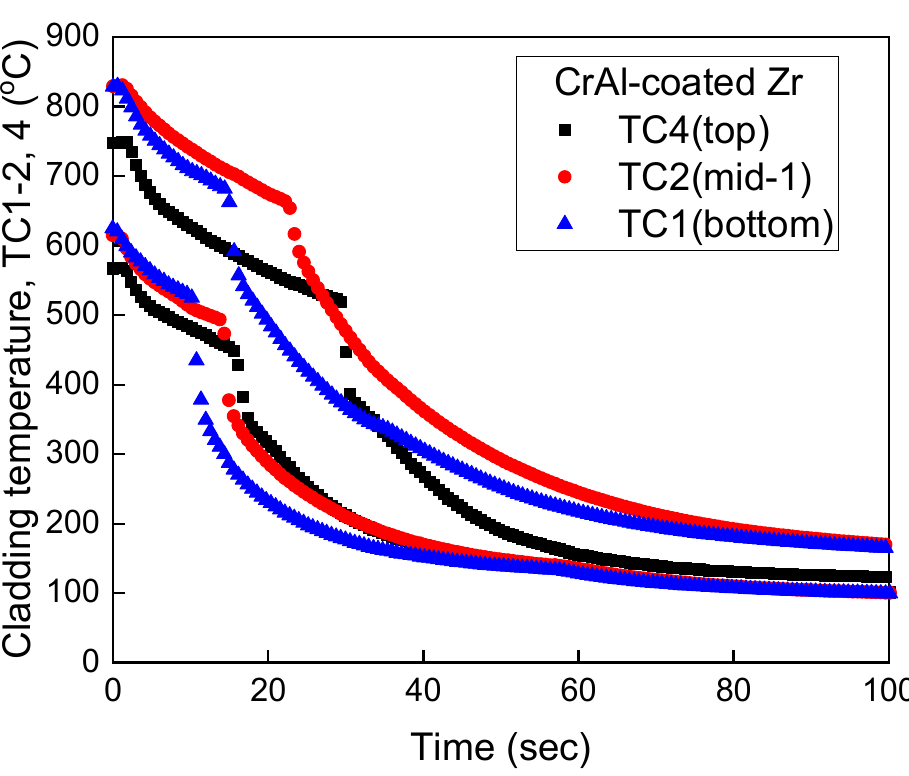
Figure 12. Effect of initial cladding temperature for the CrAl-coated Zr quenching at T sub = 5 °C and Vc = 0.05 m/s.